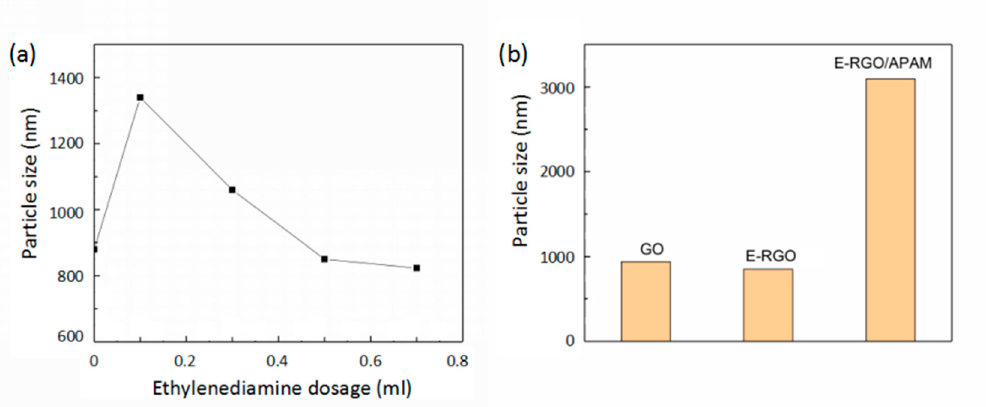
Figure 1. ( a ) ethylene diamine-reduced graphene oxide (E-RGO) particle size of different ethylenediamine dosage; ( b ) particle size of graphene oxide (GO), E-RGO and ethylene diamine-reduced graphene oxide/anionic polyacrylamide (E-RGO/APAM).